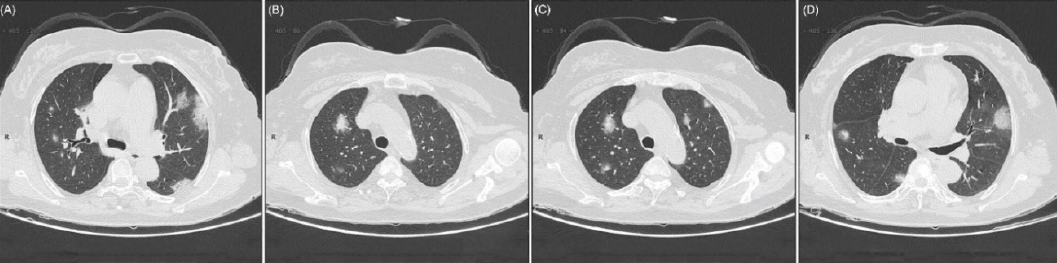
Figure 3. Atypical CT imaging of a 56-year-old female presented with a history of 3 days of persistent fever. Laboratory findings: reduced total protein level (54.0 g / L), reduced albumin value (35.5 g / L), low value of globulin (18.5 g / L), white blood cells (WBCs) (4.87 × 10 9 / L), lymphocytes (0.49 × 10 9 / L), and decreased level of eosinophil (0 × 10 9 / L). Imaging inspection: ( A ) A lateral section of the center of right lung lobe covered GGO. ( B ) Patchy GGO in the upper part of the right lung with sporadic consolidated lesions. ( C ) GGO in both lungs with sporadic consolidation lesions. ( D ) Uneven GGO in the middle and dorsal section of the right lung. Adopted from Kui et al. through open-access license [69].